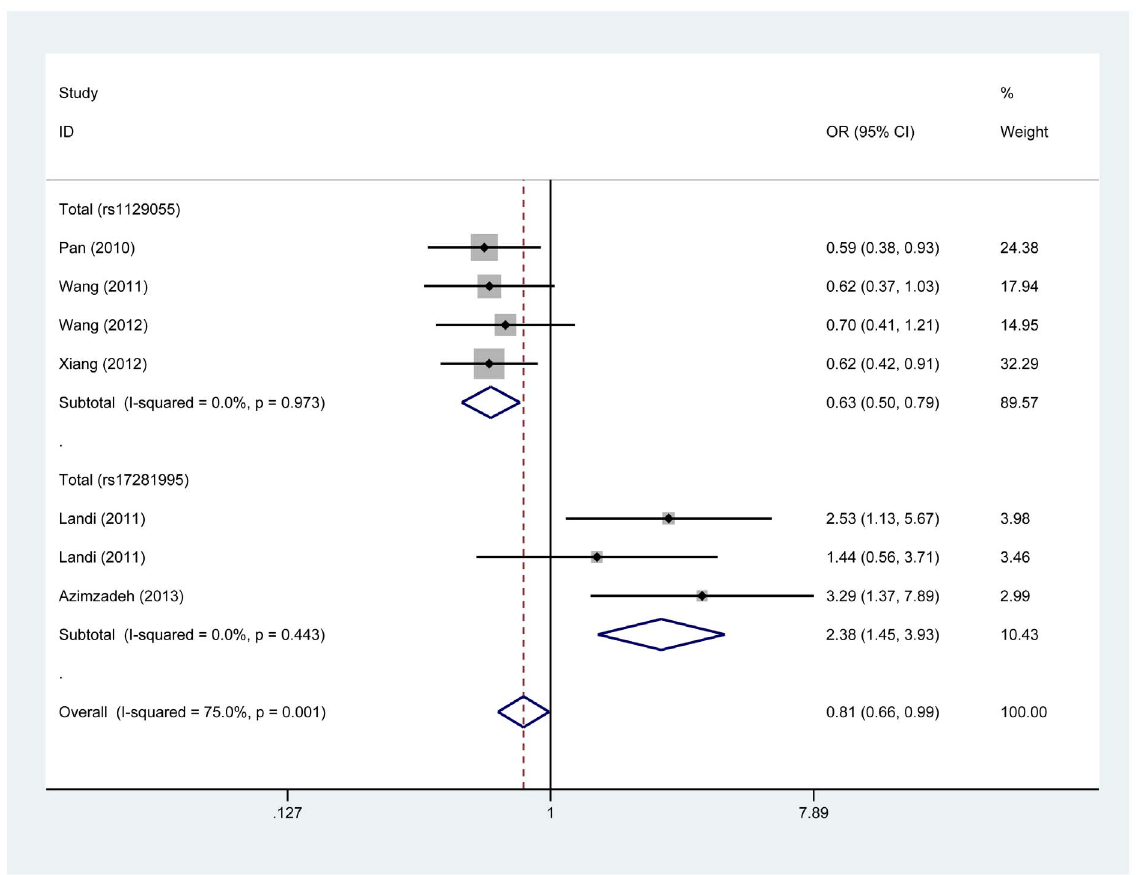
Figure 3. Forest plot of estimates of the odds ratios (ORs) for CD86 polymorphisms in cancer under GG versus GA + AA for rs1129055 and CC versus GC + GG for rs17281995. The squares and horizontal lines correspond to ORs and 95% CIs of specific study, and the area of squares reflects study weight (inverse of the variance). The diamond represents the pooled ORs and its 95% CIs.